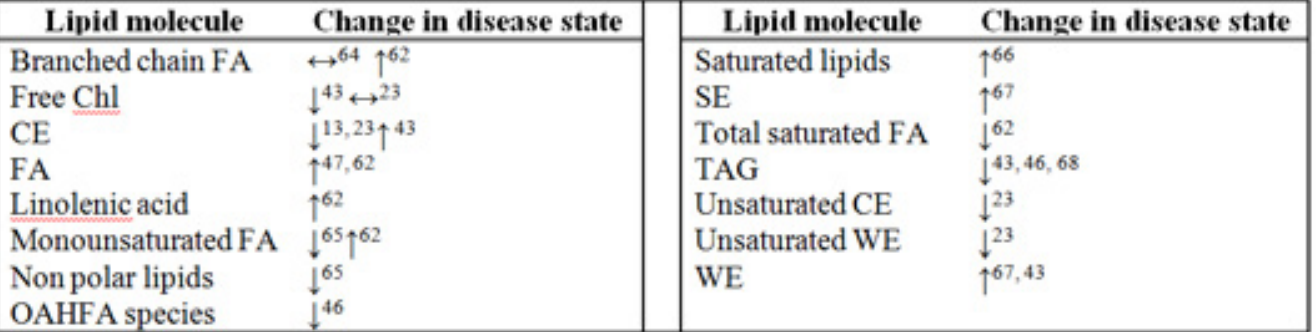
Table 2. Overview of relative levels of meibum lipids in tears of subjects suffering from blepharitis, meibomian gland dysfunction and environmental factors that have an effect on dry eye disease found by different investigators. ↔ No change in lipid level compared to control; ↑ Increase in lipid level compared to control; ↓ Decrease in level compared to control. CE, cholesteryl esters; FA, free fatty acids; Free Chl, cholesterol; SE, sterol esters; TAG, triacylglycerols; WE, wax